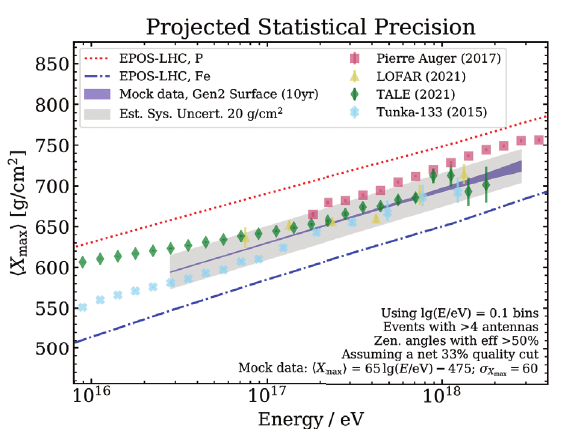
Figure 13: Projected precision from surface radio antennas for a measurement of X max using 10 years of mock data and an IceCube-Gen2 detector [23].